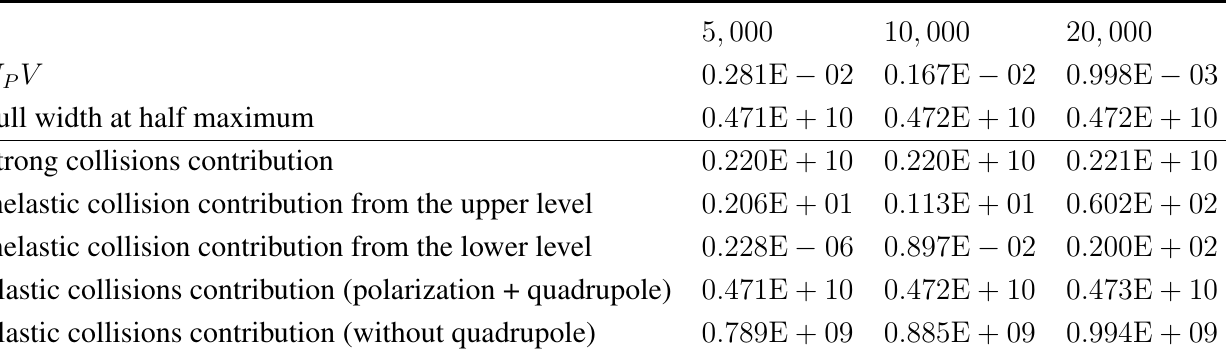
Table 6. Results of the SCP code for Li I 2 s − 2 p , proton collisions. Angular frequency = 10 16 cm − 3 , temperatures T in units, density N P